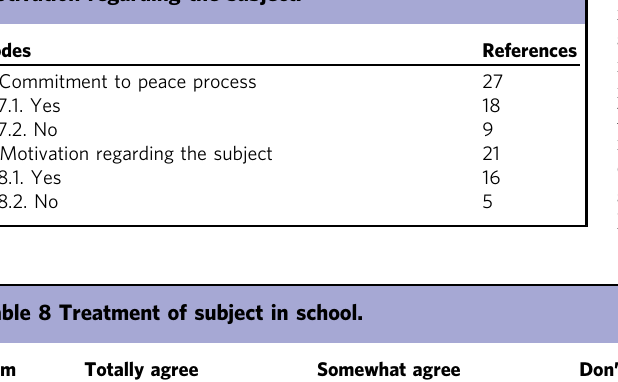
Table 7 Narratives: No. of references to commitment and motivation regarding the subject.